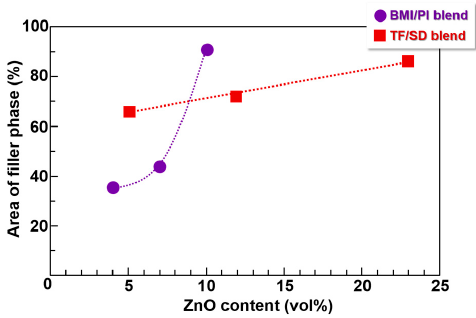
Figure 7. Variation in the area containing n-ZnO particles with the ZnO content for BMI/PI and TF/SD blend films.